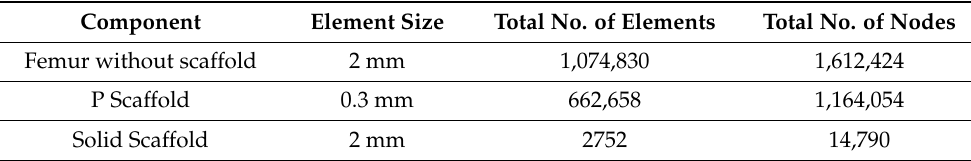
Figure A2. ( Left ): The cross − sectional images of the femur in axial, coronal, and sagittal views show the threshold of the bony area. ( Right ): Generated 3D solid model of femur used in the study. Table A1. Number of elements and nodes generated in each component of the model for finite element analysis.